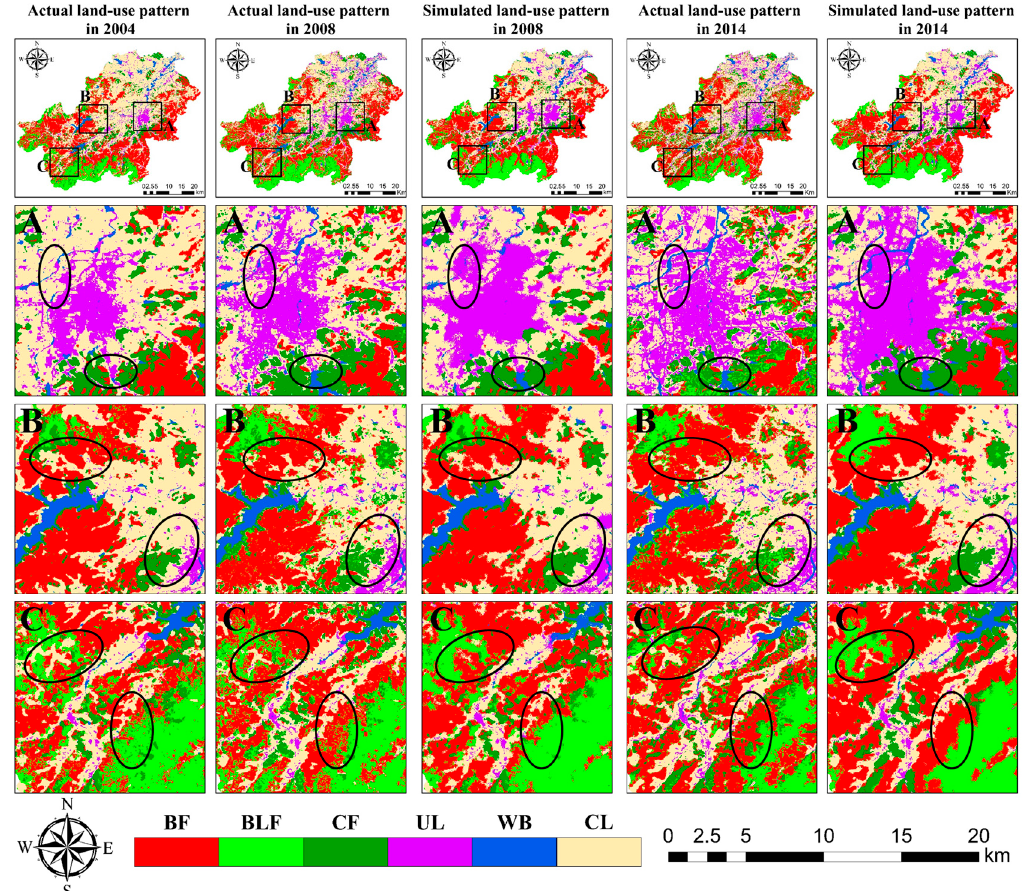
Figure 9. The simulated spatial pattern of land cover from 2004 to 2014.